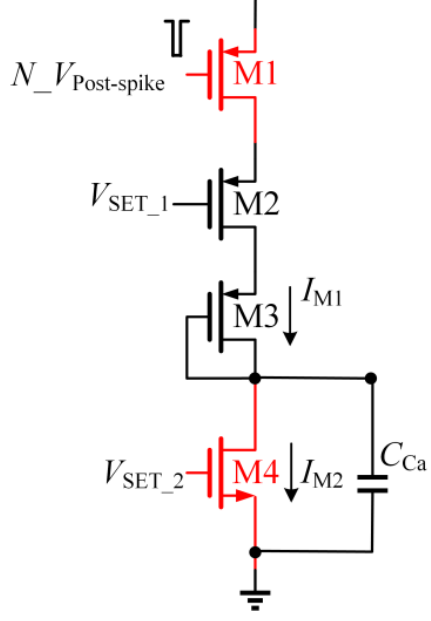
Figure 11. Spike monitoring module after irradiation.